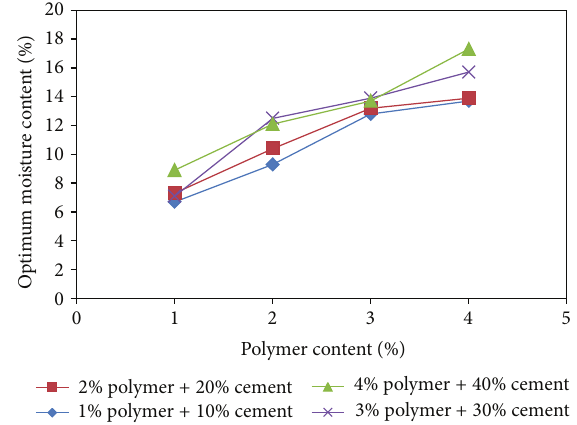
Figure 12: Effect of polymer content on OMC in dry conditions for 7 days.